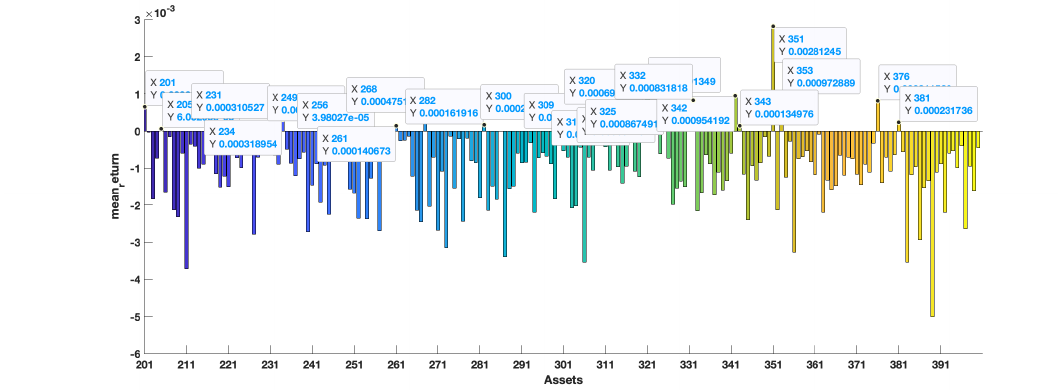
Figure 5. The mean return of the out-of-sample data range from the 101st asset to the 200th asset.